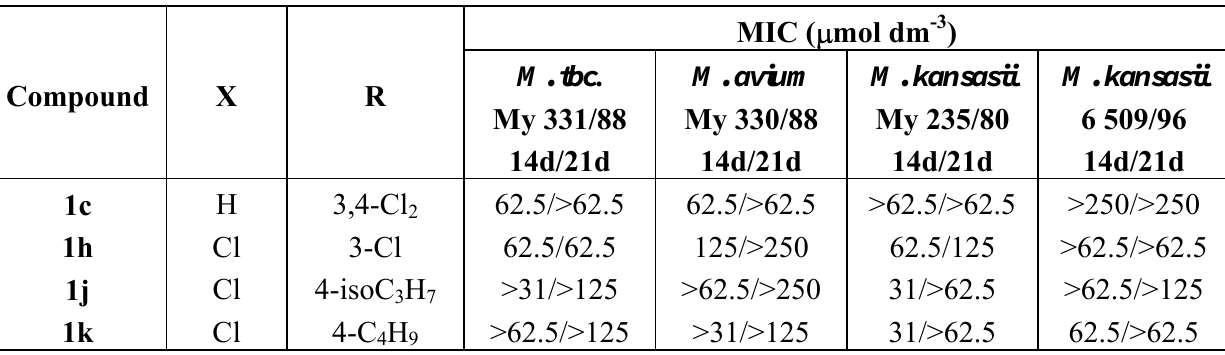
Table 3. Antimycobacterial activity of compounds 1 and 2 expressed as MIC ( µ mol dm -3